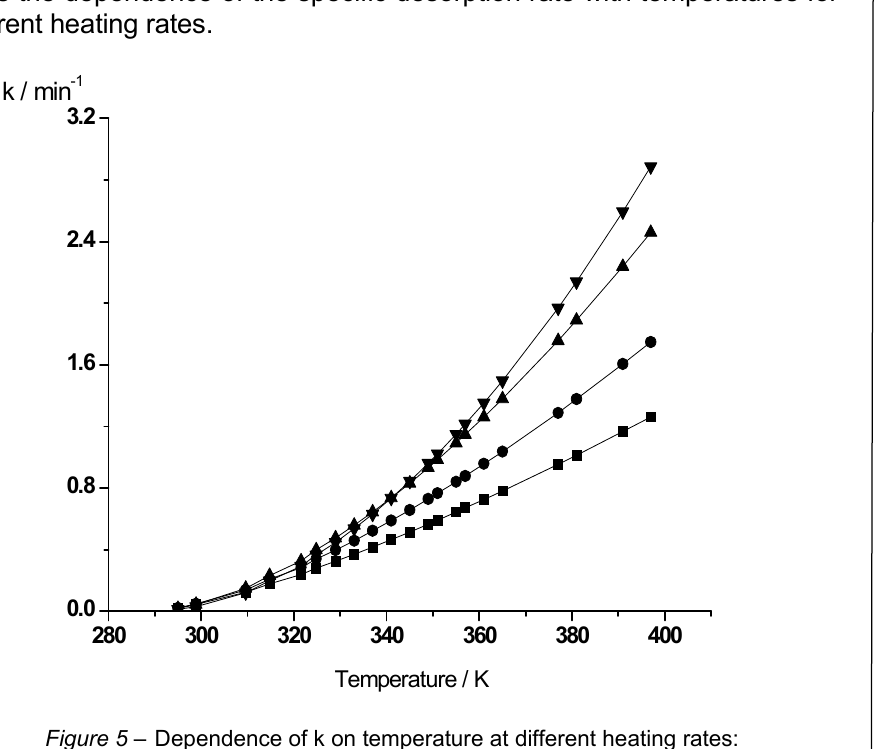
Figure 5 – Dependence of k on temperature at different heating